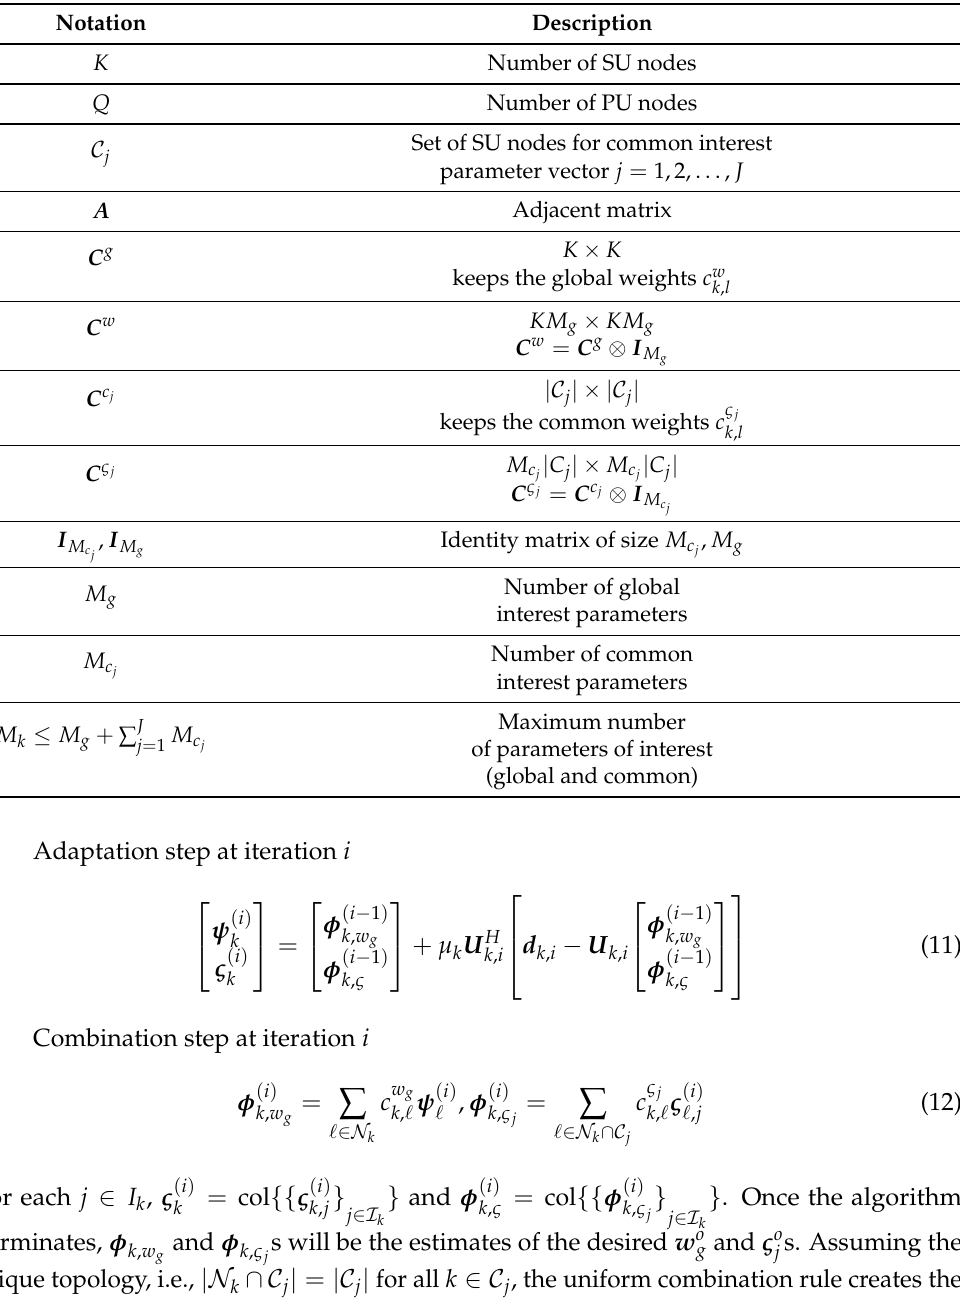
Table 1. List of